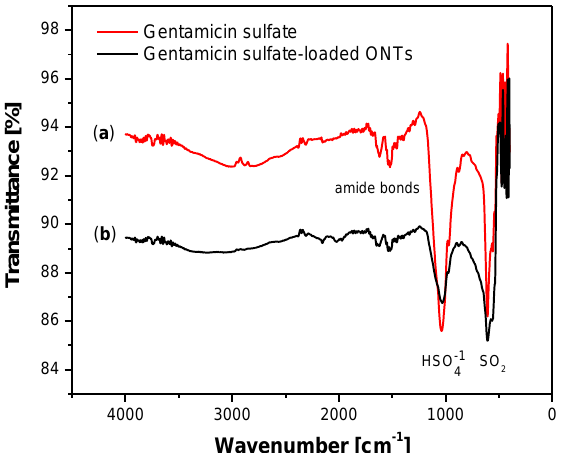
Figure 10. ATR-FTIR spectrum collected for: ( a ) gentamicin sulfate; ( b ) gentamicin sulfate–loaded ONTs formed on the Ti–6Al–7Nb alloy in 1 M EG + 0.2 M NH 4 F electrolyte anodized at 50 V for 60 min.